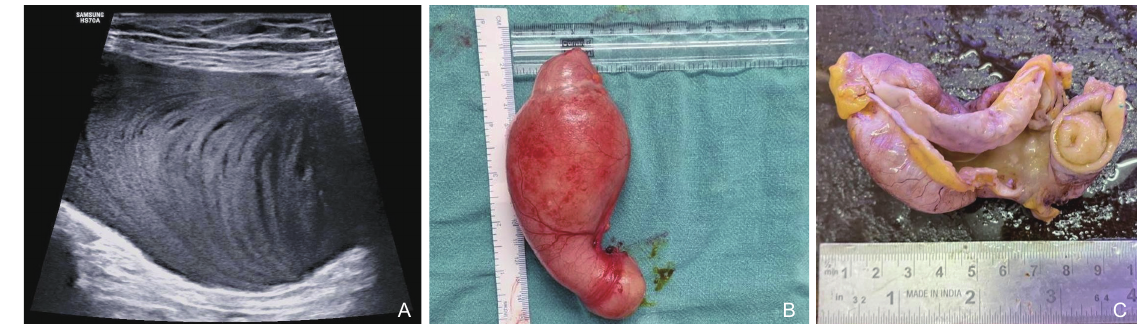
Figure 1 (A) Gray scale ultrasound showed that sonographic layering within a cystic mass due to thick fluid (onion peel appearance diagnostic for appendicular mucocele) and thickened omentum; (B) Gross specimen showed that swollen appendix measuring (14 × 4.3 cm) with the inflamed and thickened wall; (C) Cut section of appendix showed that cystically dilated appendix and revealed mucus-like